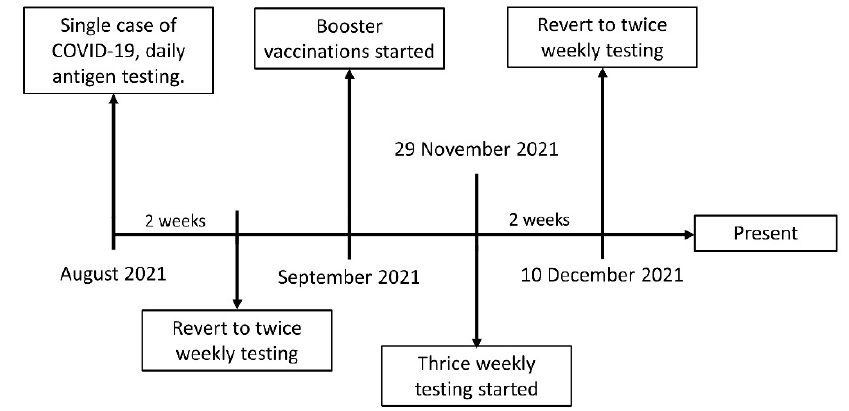
Figure 1. Timeline of SARS-CoV-2 rapid antigen testing from August 2021 to present.